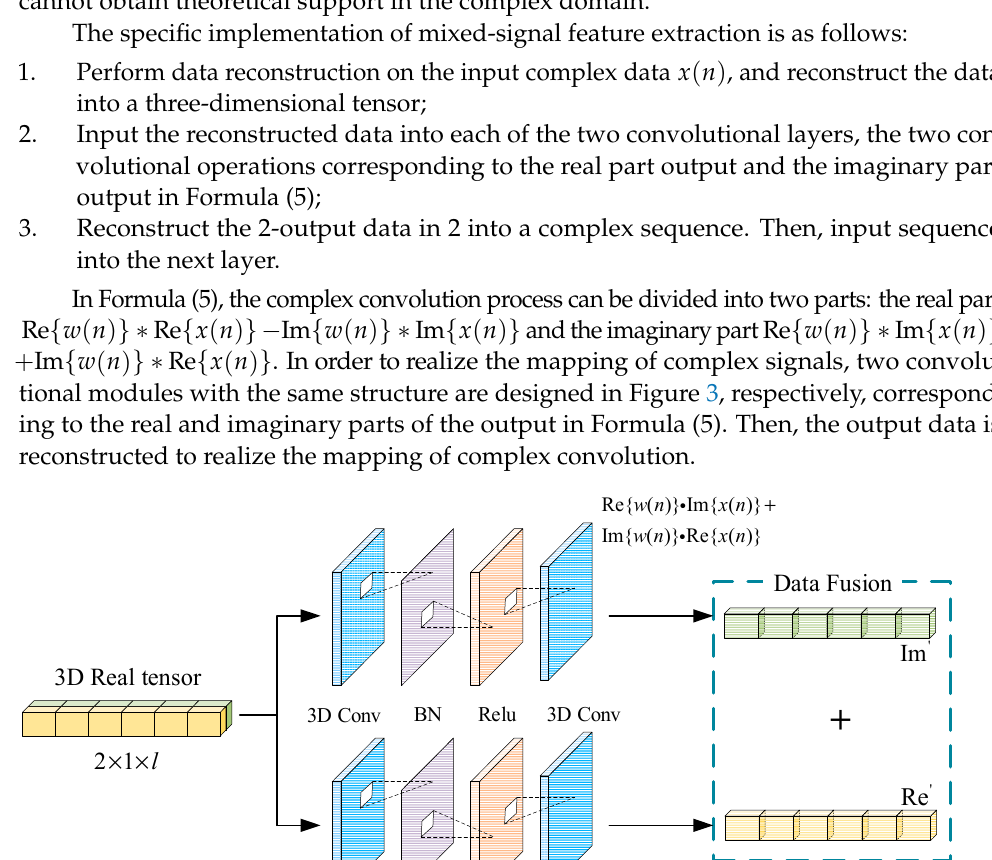
Figure 2. Data reconfiguration diagram.